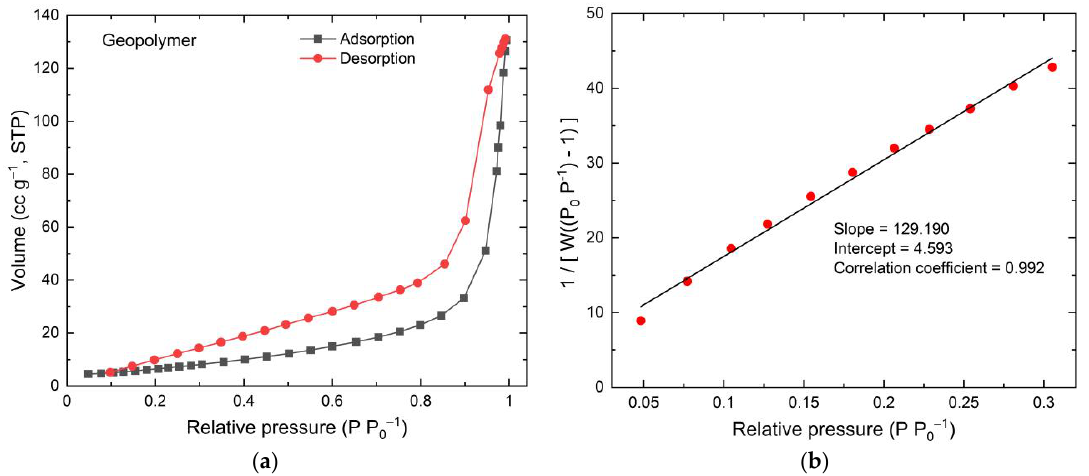
Figure 12. BET result of geopolymer ( a ) isotherm, and ( b ) multi-point BET.